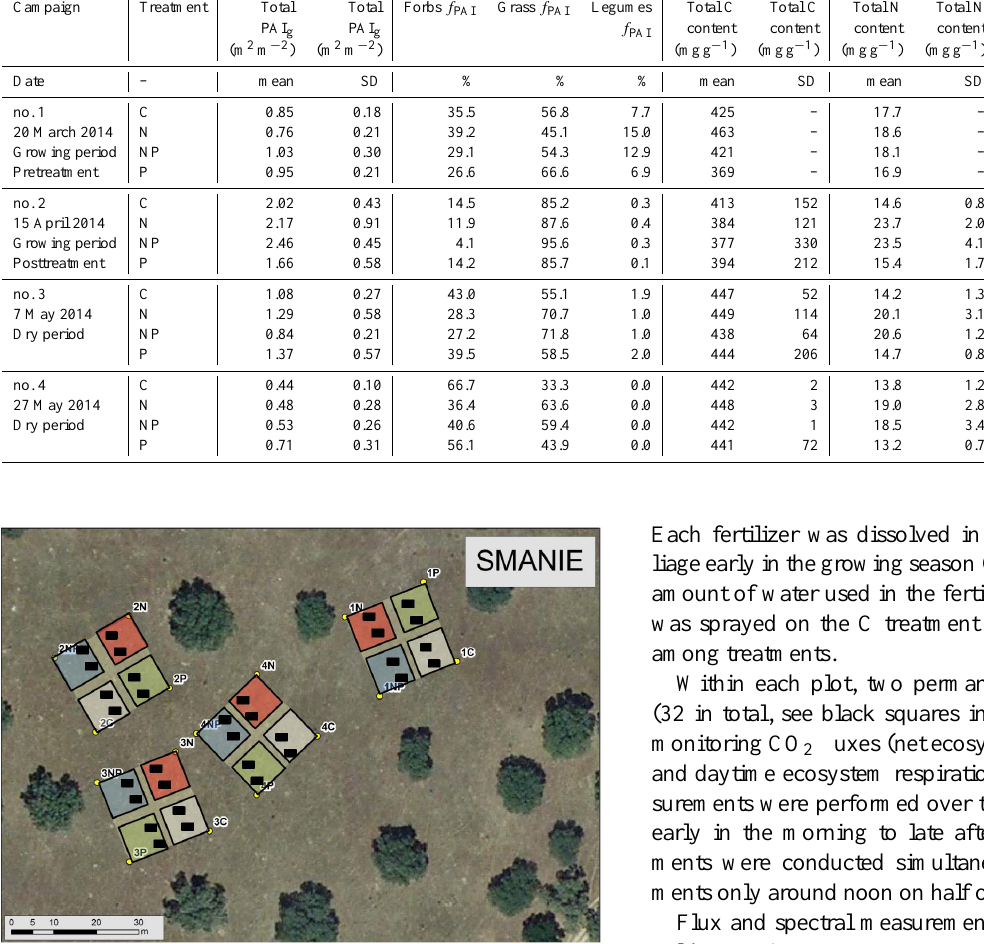
Figure 1. Overview of the experimental site (SMANIE): the experi- mental blocks are drawn on an image acquired with the 80-band air- borne hyperspectral line-scanner radiometer (Sensytech Inc., Bev- erly, MA, USA) sensor during April